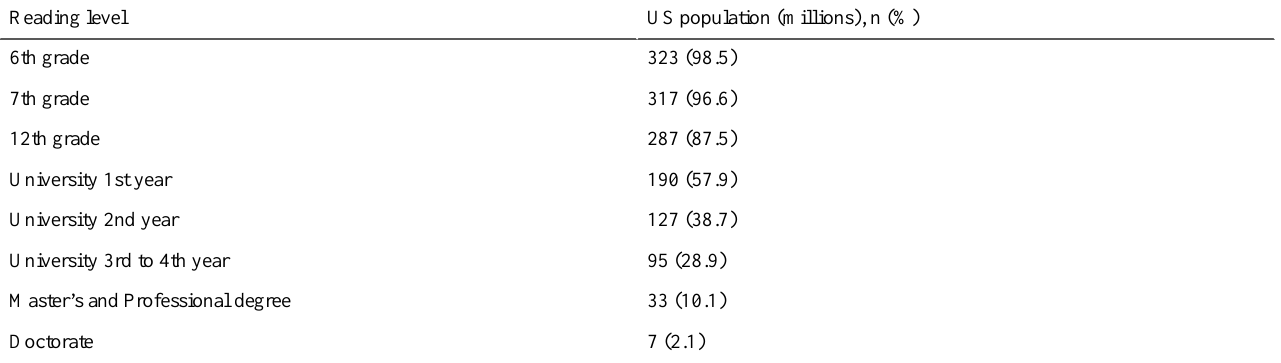
Table 4. American population according to reading level (N=328